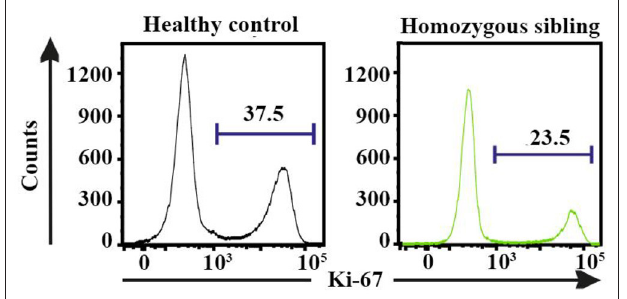
FIGURE 5 | The proliferative (Ki-67 + ) response for staphylococcal enterotoxin B-specific CD8 + T cells following 3-day stimulations in the homozygous patient and a healthy